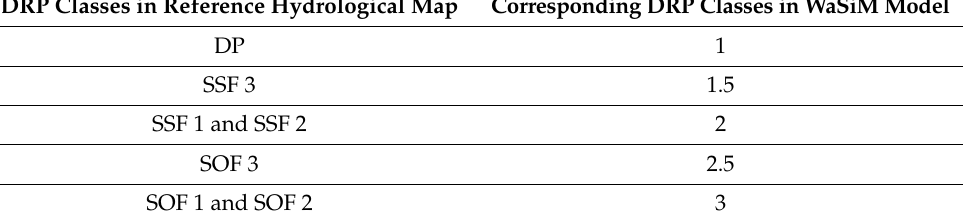
Table 5. Reclassification of the soil hydrologic map corresponding to the hydrological model DRP